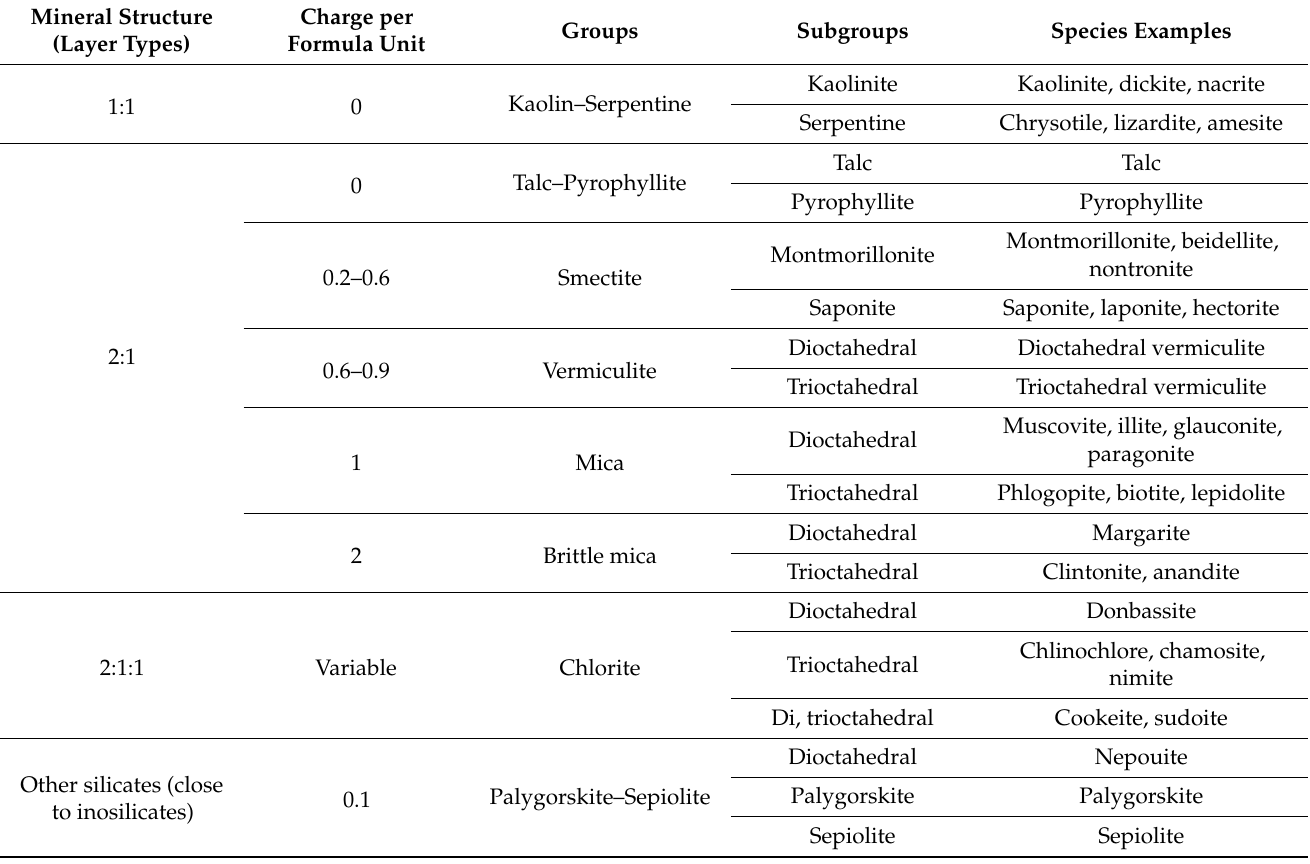
Table 2. Classification of clay minerals based on the Si–O tetrahedra/Al–OH octahedra ratio and the surface charge layer